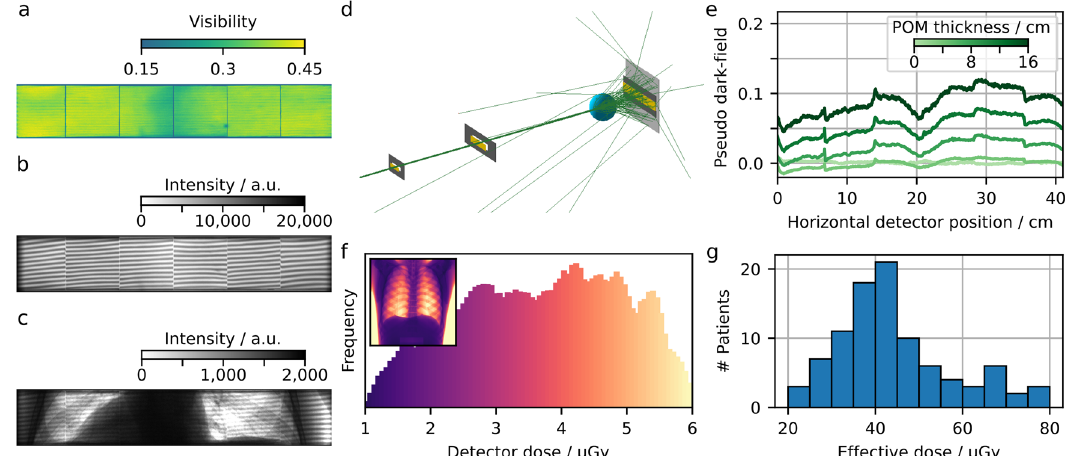
Fig. 3 Optimising the interferometer for the detection of pulmonary pathologies. a Interferometric visibility map, which is a measure of the setup sensitivity. b One exemplary raw image frame without and c with a patient in the beam path. The changes in the interference pattern induced by a sample allow for (conventional) attenuation- and (novel) dark- fi eld image extraction. d Monte-Carlo simulation of Compton scatter, adapted for setup-speci fi c parameters. Based on such simulations, a correction for Compton scatter-induced dark- fi eld contribution was applied. e Beam hardening induced by an equivalent material (here polyoxymethylene, POM). We implemented a beam hardening correction based on POM, assuming similar spectral behaviour between calibration material and patient. f Dose histogram of the lung region and detector dose map of a thorax phantom (inlet). g Histogram of effective dose deposited in the patients. For the patients described here, we report a mean (median) effective dose of 46.6 (41.7) µ